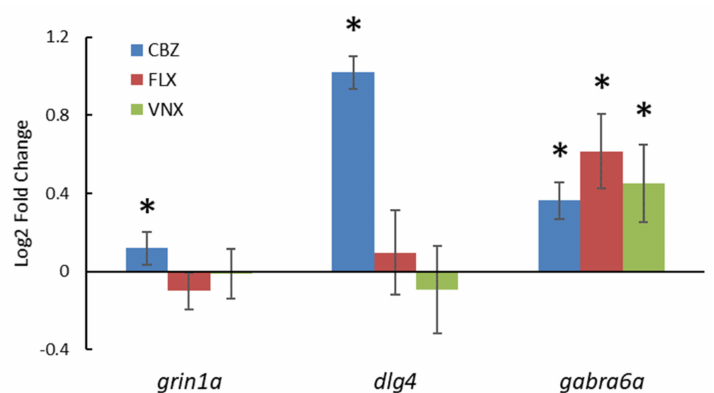
Figure 4. Effects of test compounds on marker gene expression. Gene expression analysis after 120 h of exposure to 115 µ M CBZ, 107 µ M VNX, and 6 µ M FLX. The results are the average of n = 6 pools of embryos (each pool containing 12 embryos), expressed by using the delta–delta cycle threshold method (2 – ∆∆ Ct ). The asterisk (*) indicates significance, p < 0.05. Error bars,